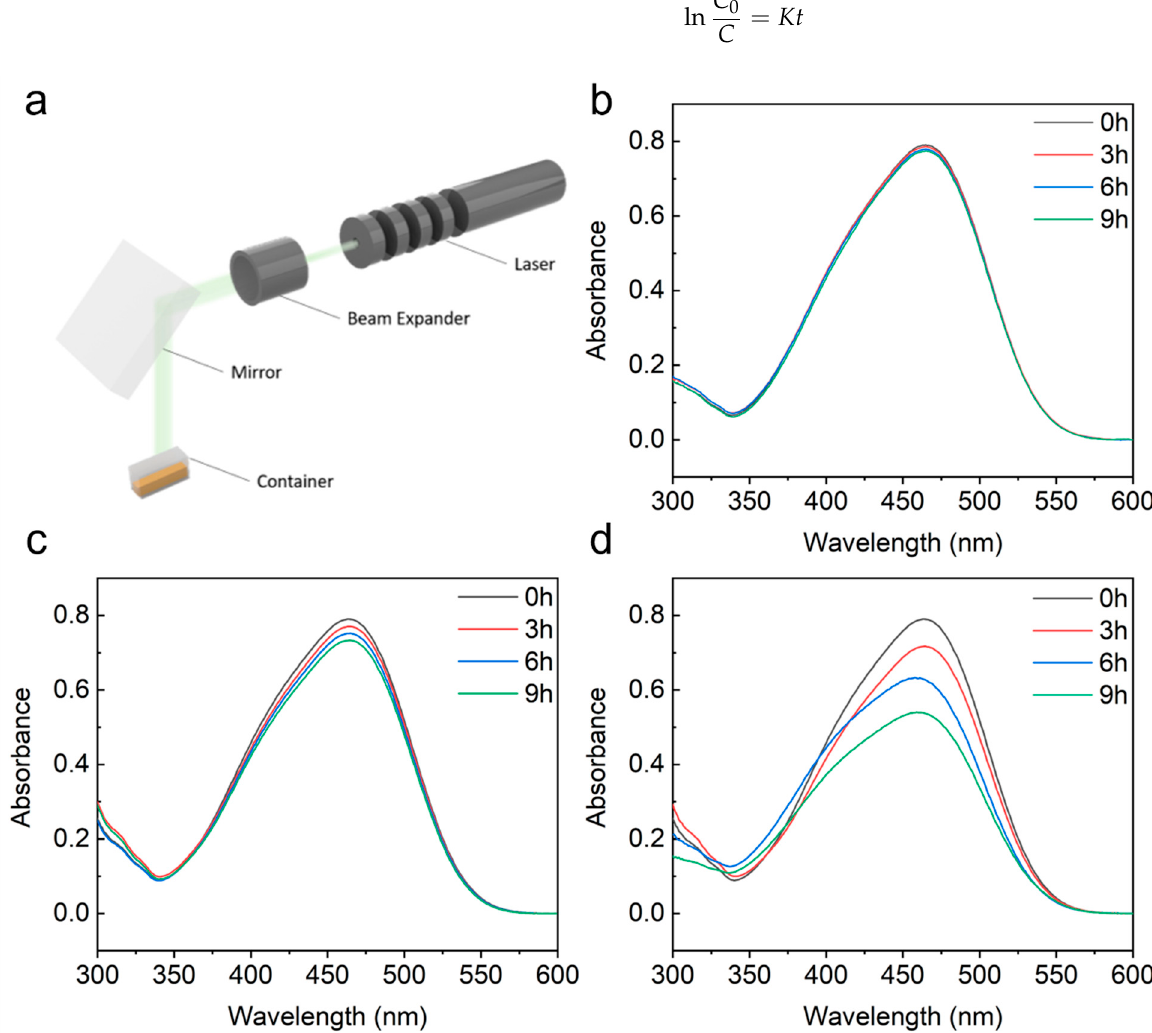
Figure 4. ( a ) Schematic of photocatalysis experiment set up. ( b – d ) UV–Vis spectra of MO aqueous solution before and after 3 h, 6 h, 9 h visible light exposure using 2 nm TiO 2 film, isolated nanofingers and collapsed nanofingers as photocatalysts.